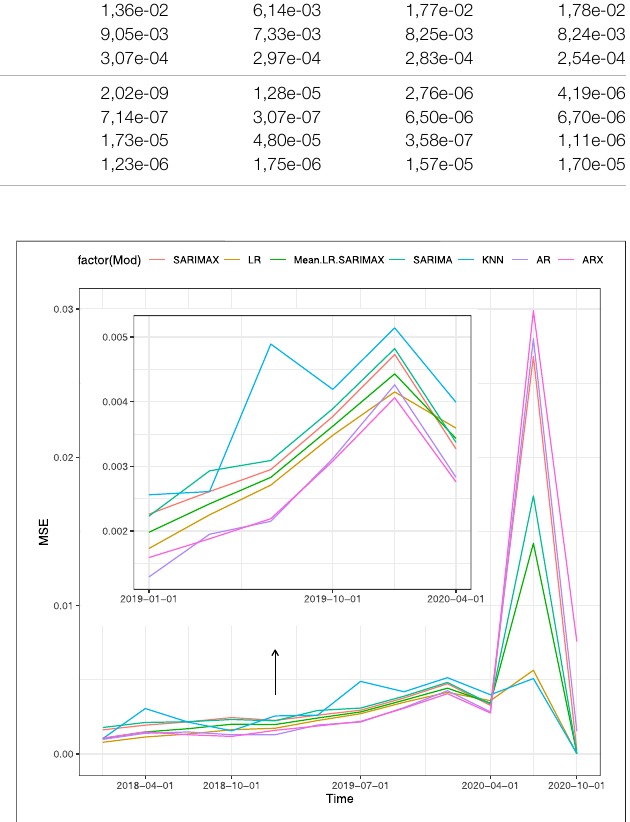
FIGURE 3 | MSE of the models for one-step-ahead, Scenario 4, sensitiveness to the pandemic shock.